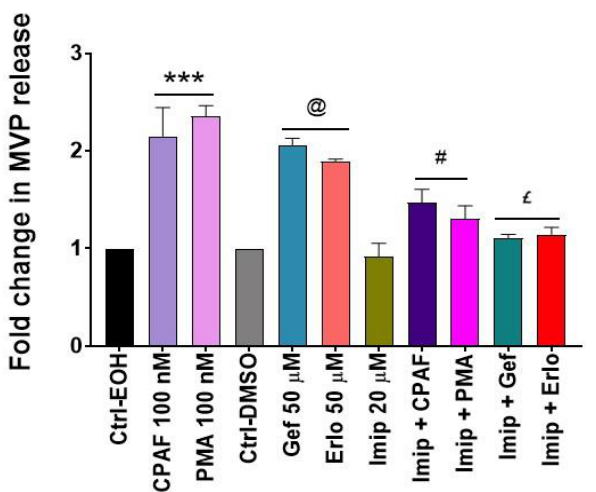
Figure 5. Acid sphingomyelinase (aSMase) inhibition abrogates gefitinib-induced MVP release. A549 cells were pretreated with aSMase inhibitor, imipramine (Imip; 20 µM, 1 h) followed by the treatments with 0.1% EOH or DMSO as vehicle controls, 100 nM CPAF or PMA as positive controls, and 50 µM Gef or Erlo. After 4 h of incubation, MVPs were isolated and quantified. Data are mean ± SE from three independent experiments, normalized per 1 × 10 6 cells, and represented as Fold change in MVP release over various treatment groups. Statistically significant differences were observed between Ctrl-EOH and CPAF or PMA (*** = p < 0.001); ctrl-DMSO and Gef or Erlo (@ = p < 0.001); CPAF vs. Imip + CPAF or PMA vs. Imip + PMA (# = p < 0.05); Gef vs. Imip + Gef or Erlo vs. Imip + Erlo (£ = p < 0.01).